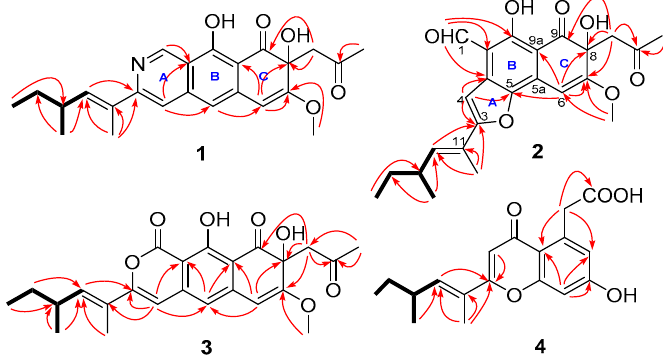
Figure 2. dqfCOSY (bolds) and selected HMBC (single head arrows, red) correlations of compounds 1 − 4 .